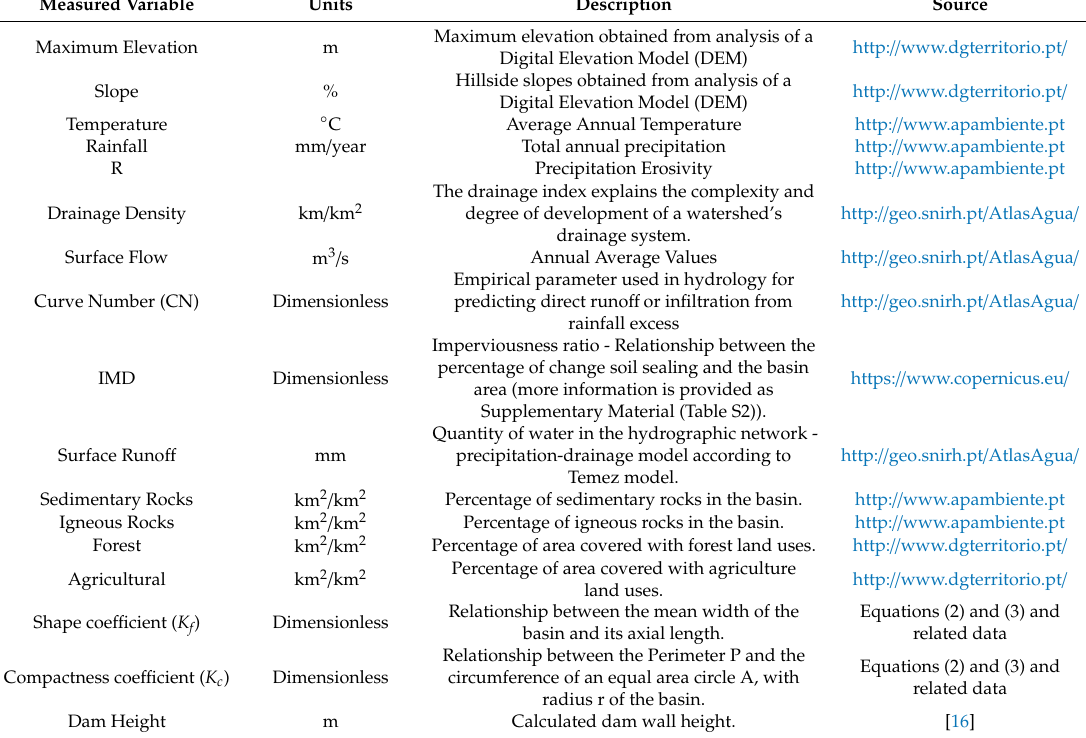
Table 3. List of measured variables used as source data for Partial Least Squares–Path Modeling (PLS-PM). Besides identification of variables, their measurement units and description, the table contains indications about usage in the PLS-PM models and on the data